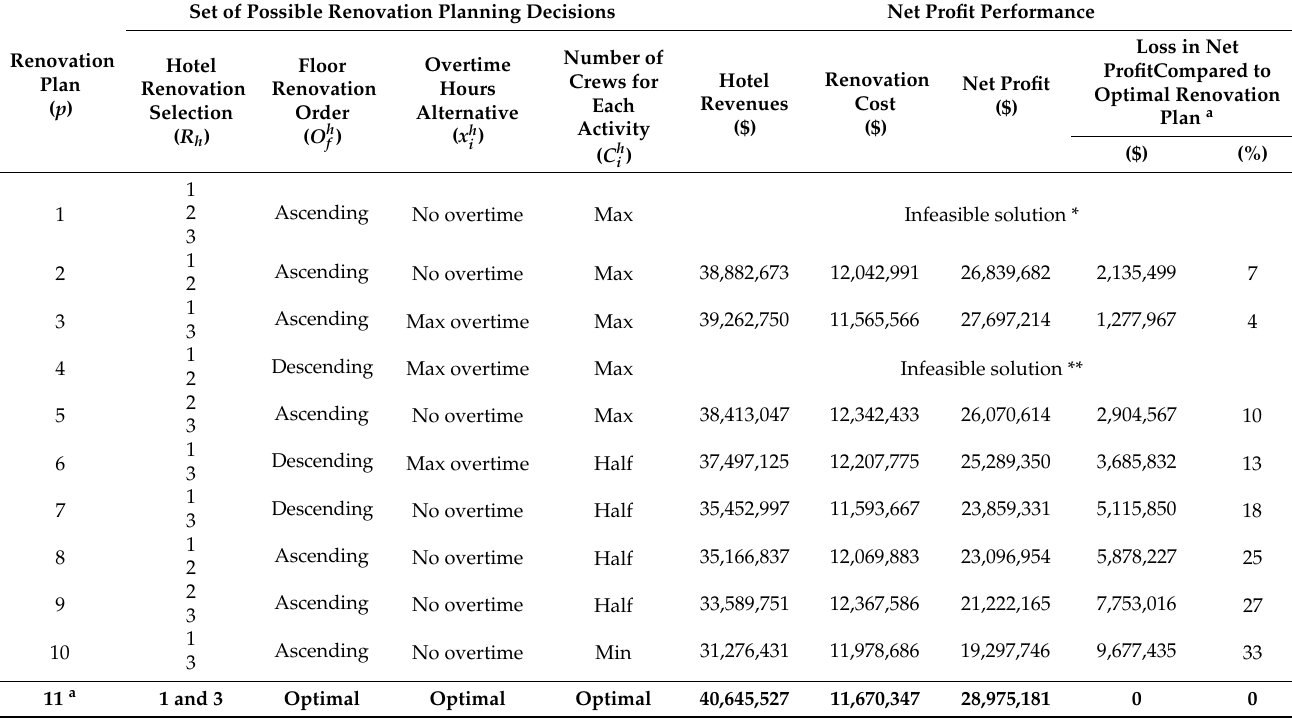
Table 10. Sample set of possible renovation